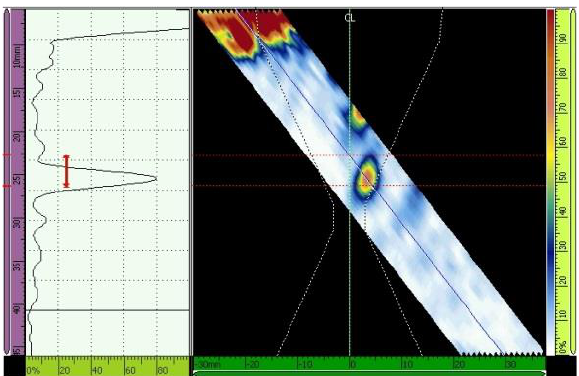
Figure 17. Echo (maximized to 80% of the screen height) from the third hole. Scanning angle of 52°,